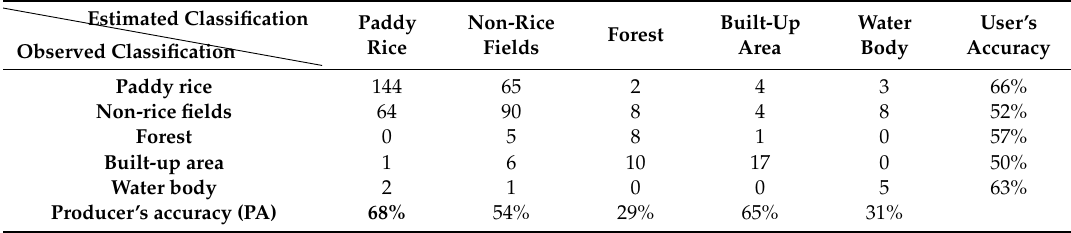
Table 5. Confusion table of the combination of VV and VH and EVI without VV and VH bands in